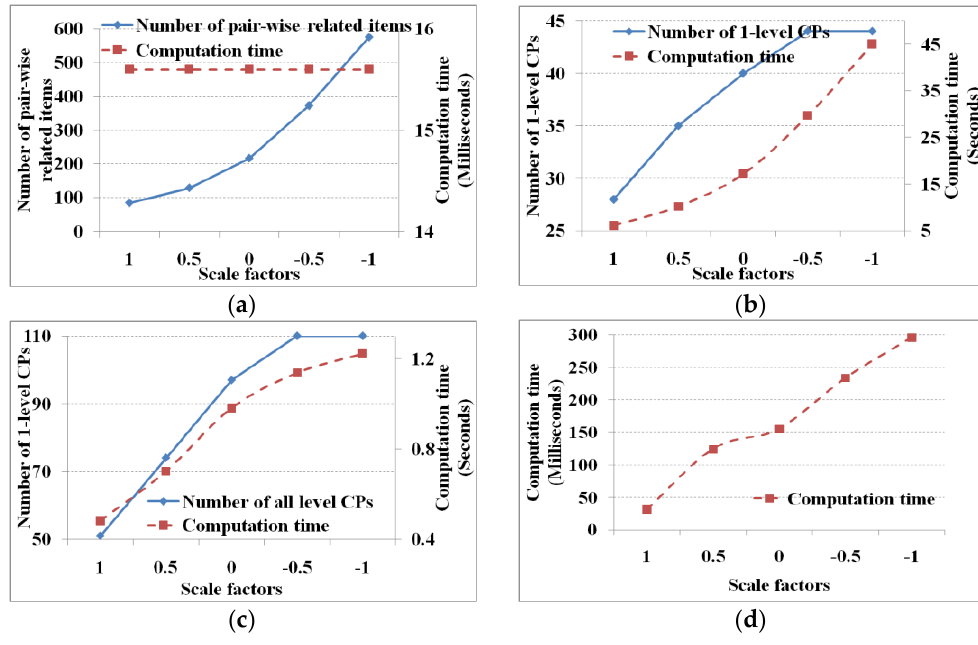
Figure 3. Performance under different scale factors of mutual information threshold. ( a ) Number of pair-wise related items and computation time; ( b ) Number of one-level cascading patterns and computation time; ( c ) Total number of cascading patterns and computation time; ( d ) Computation time of linking and pruning.